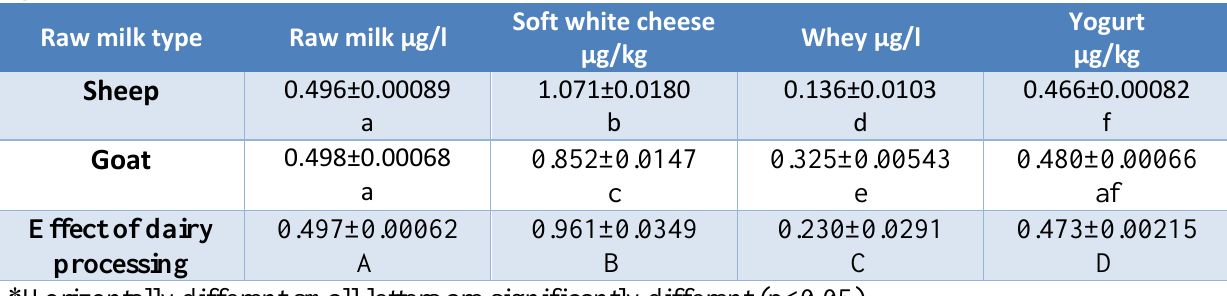
Effect of dairy processing